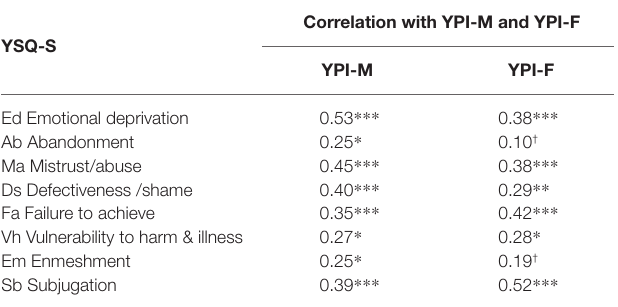
Correlation with YPI-M and